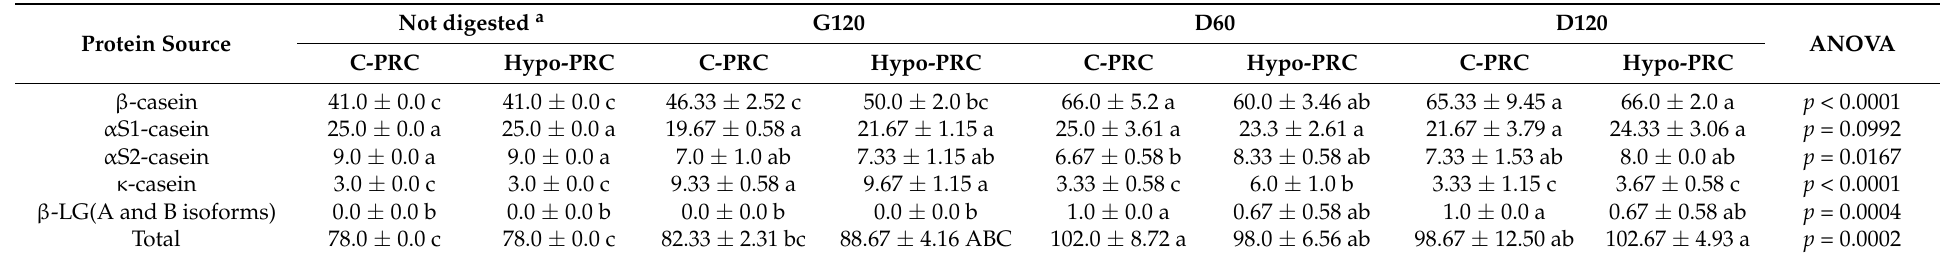
Table 2. Number of different peptides released in conventional Parmigiano Reggiano cheese (C-PRC) and hyposodic Parmigiano Reggiano cheese (Hypo-PRC) at different digestion times.